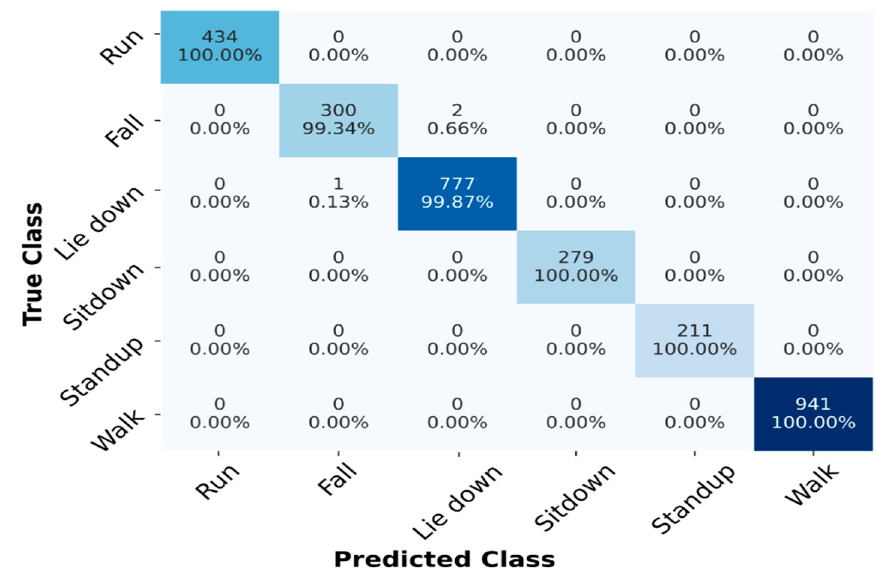
Figure 7. Confusion matrix of the proposed model on StanWiFi dataset.